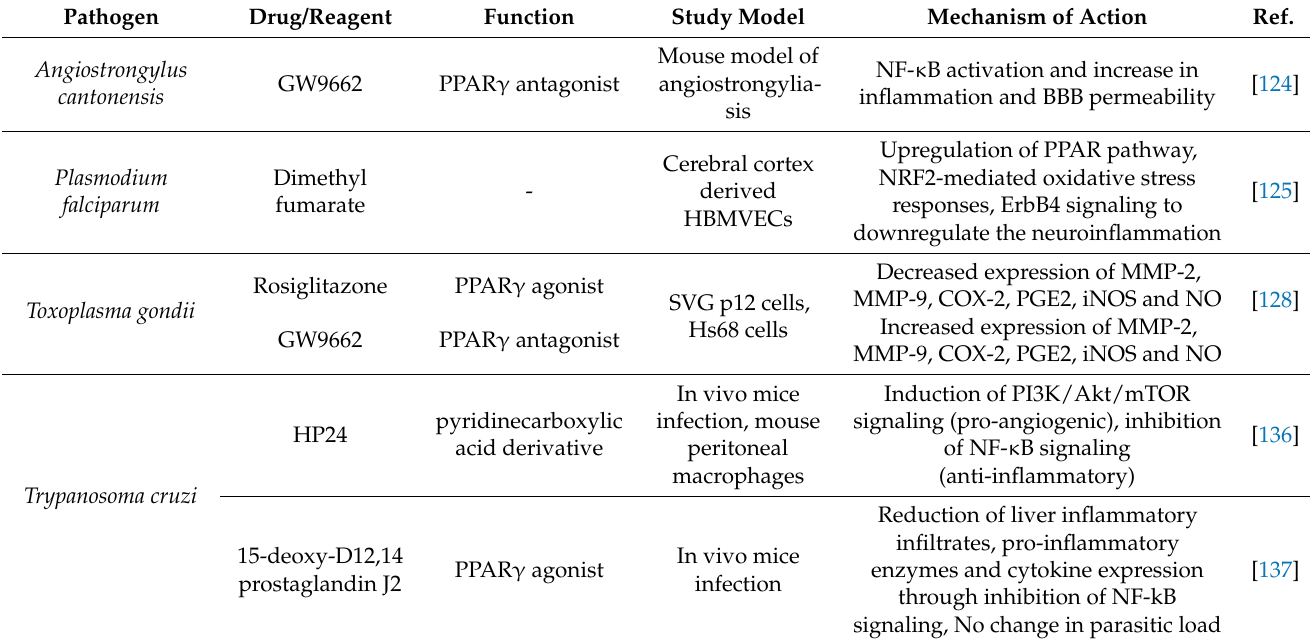
Table 3. Roles of PPAR agonists/antagonists in parasitic